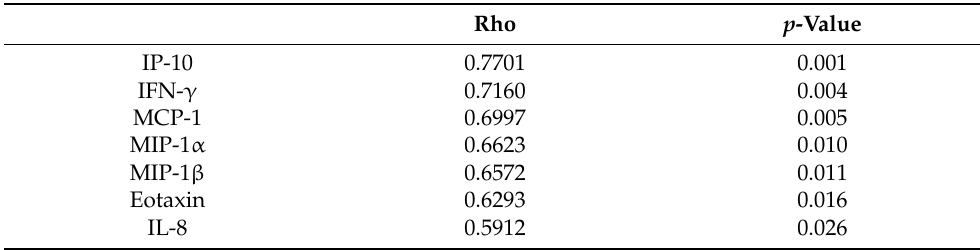
Table 2. Spearman’s rank correlation rho and p -value between the levels of inflammatory cytokines in the vitreous and axial